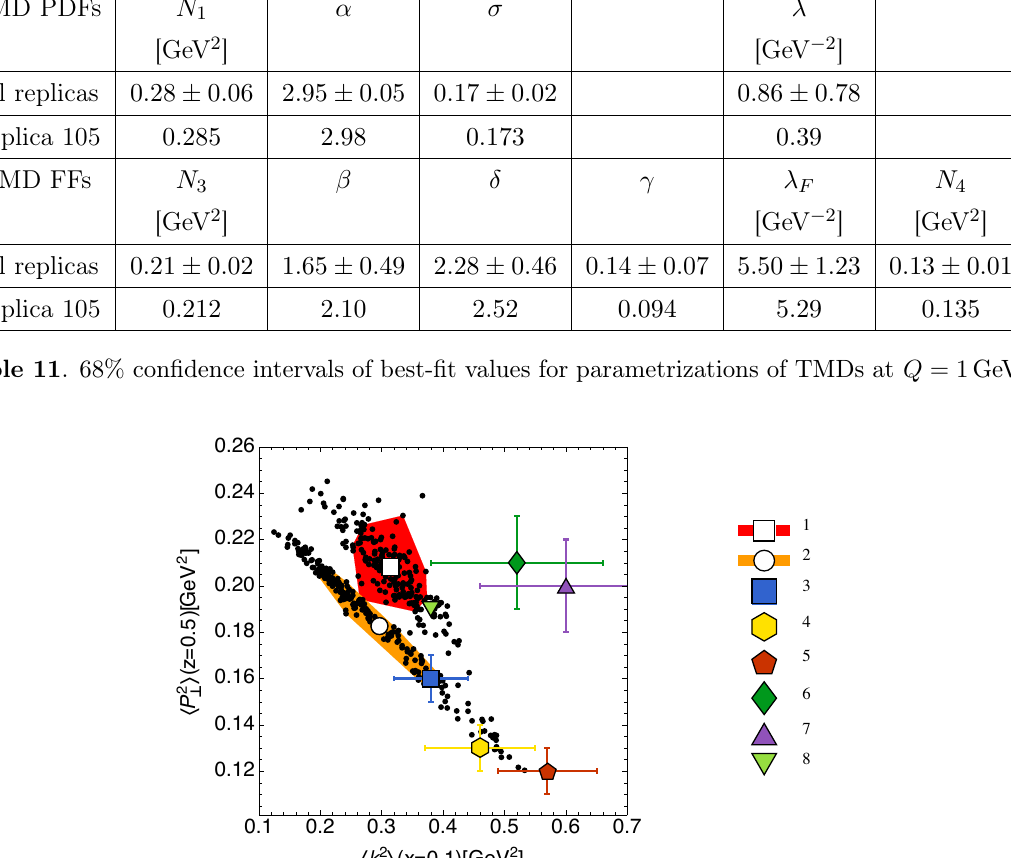
P 2 ( z = 0 : 5) , and in TMD ? i h